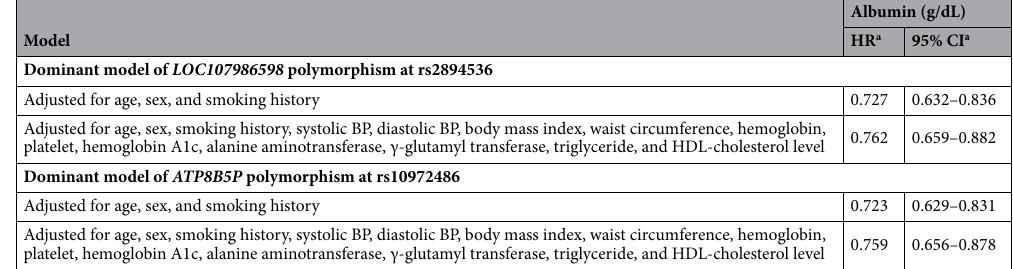
Table 5. Control function instrument variable estimator of the casual HR for the effect of serum albumin levels on HTN development. a Calculated using a two-stage residual inclusion method.